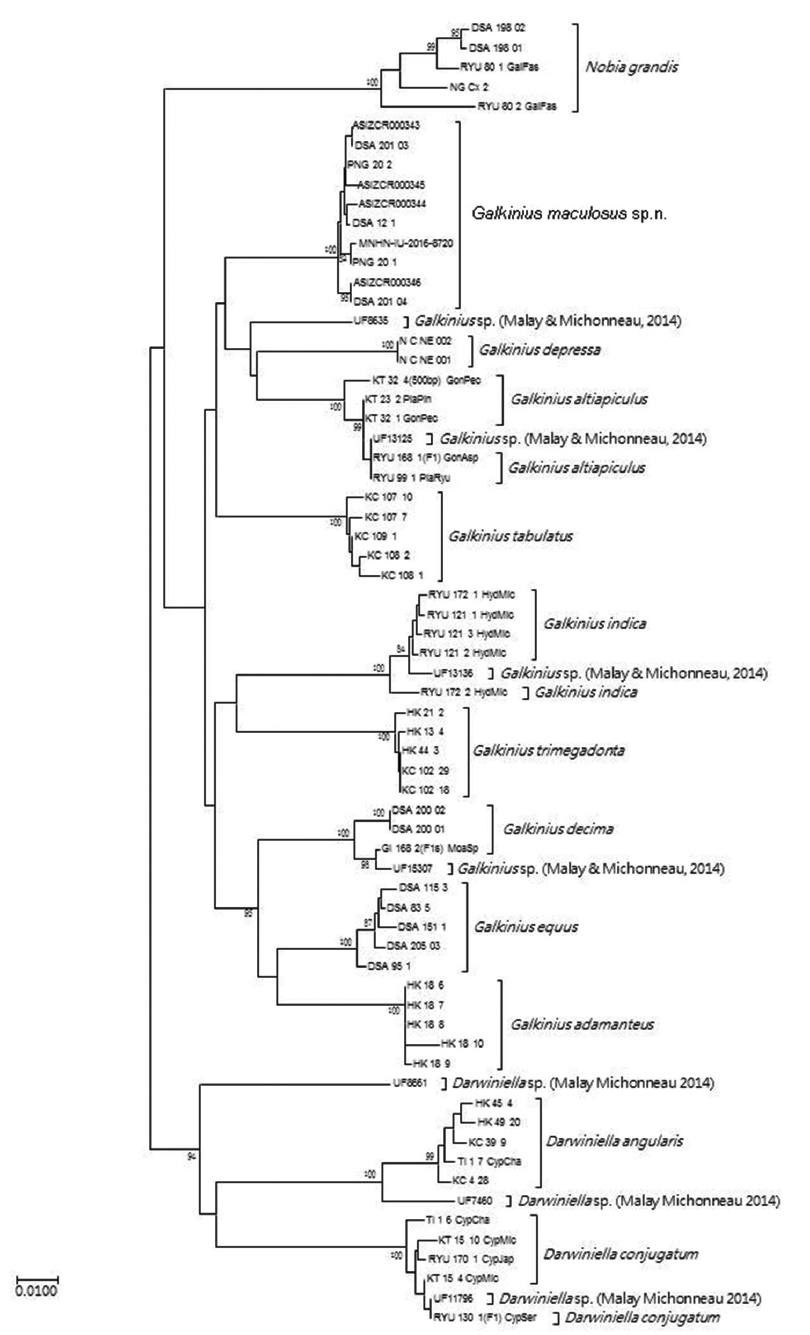
Figure 11. Neighbour-Joining (NJ) method inferred genealogical relationships of Darwiniella and Gal- kinius specimens based on 624bp 12S and COI with Nobia grandis as the outgroup. Numbers above the major nodes are bootstrap values of 1000